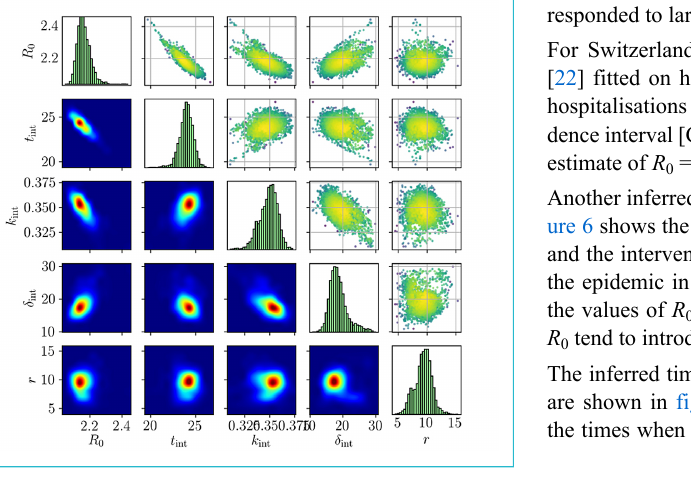
Figure 3: Inferred parameters (the basic reproduction number R 0 , intervention time t int , reduction factor after intervention k int , duration of the transition δ int and the dispersion parameter r of the negative binomial distribution [4] for Germany: samples drawn from the pos- terior distribution (upper triangle), marginal distributions of the indi- vidual parameter (diagonal) and likelihood heat map (lower trian- gle).